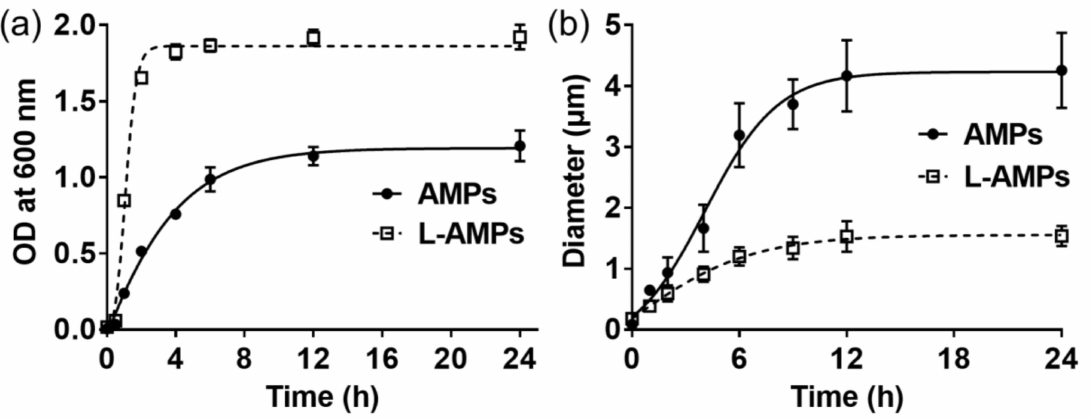
Figure 2. ( a ) Turbidity curves of reaction reflecting the nucleation and growth of AMPs and L-AMPs. ( b ) The growth of AMPs and L-AMPs over the course of 24 h self-assembly reaction at 4 ◦ C. The L-AMPs were formed with 0.1% (w/v)